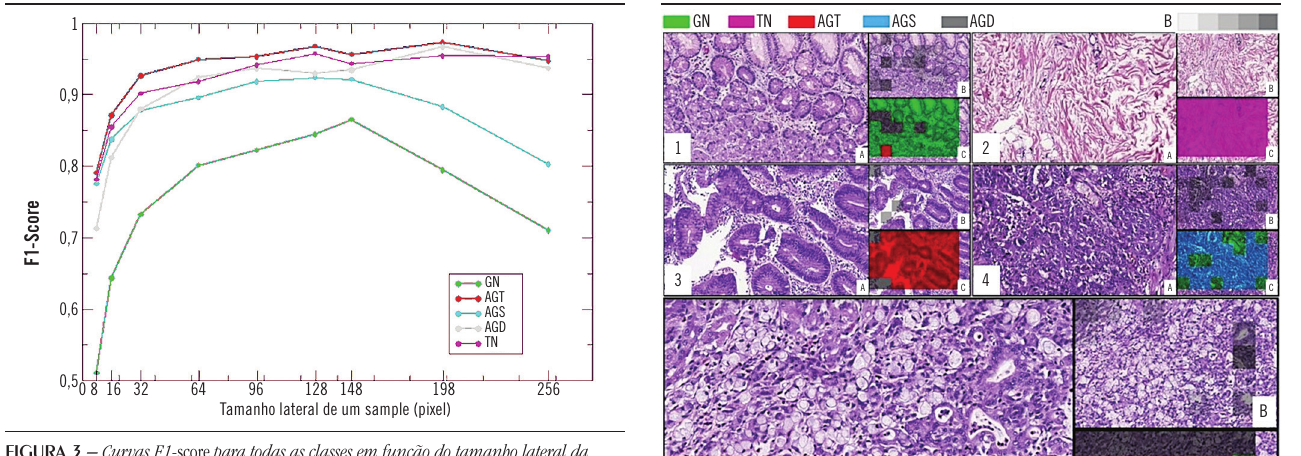
figura 3 – Curvas F1- score para todas as classes em função do tamanho lateral da amostra GN: epitélio gástrico normal; AGT: epitélio gástrico neoplásico/adenocarcinoma gástrico tubular; AGS: adenocarcinoma gástrico de tipo sólido; AGD: adenocarcinoma gástrico de tipo descoeso/difuso; TN: tecidos normais não epiteliais.